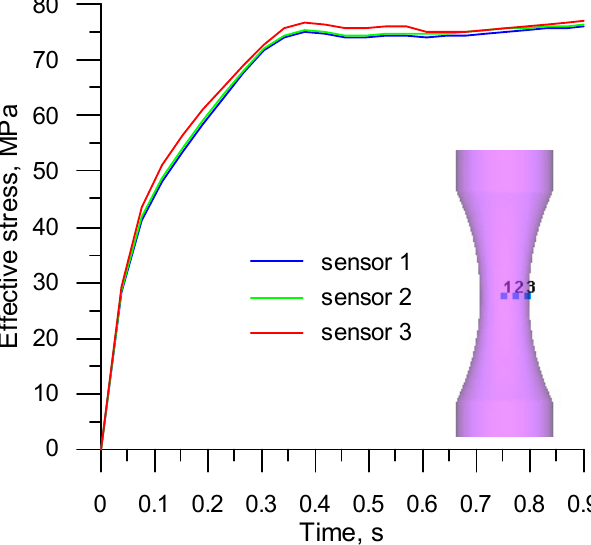
Figure 10. Variations in the effective plastic strain measured by the sensors located in the R200 steel sample under the tensile test at 1100 °C.